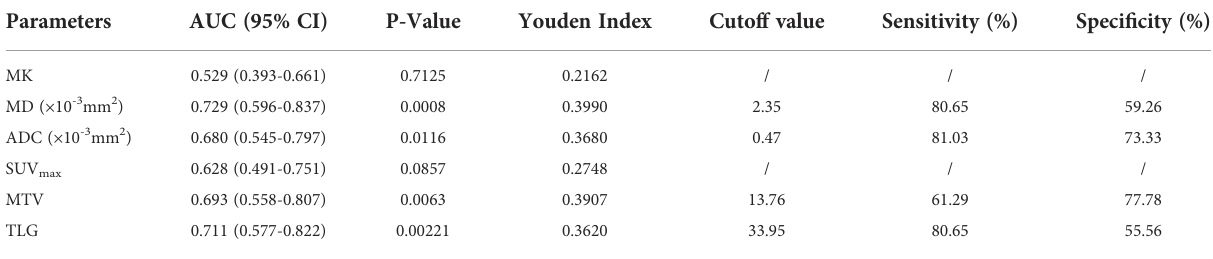
TABLE 5 Sensitivity and speci fi city of diffusion parameters at optimal cutoff values in differentiating high-grade and non-high-grade malignant SPLs. Parameters